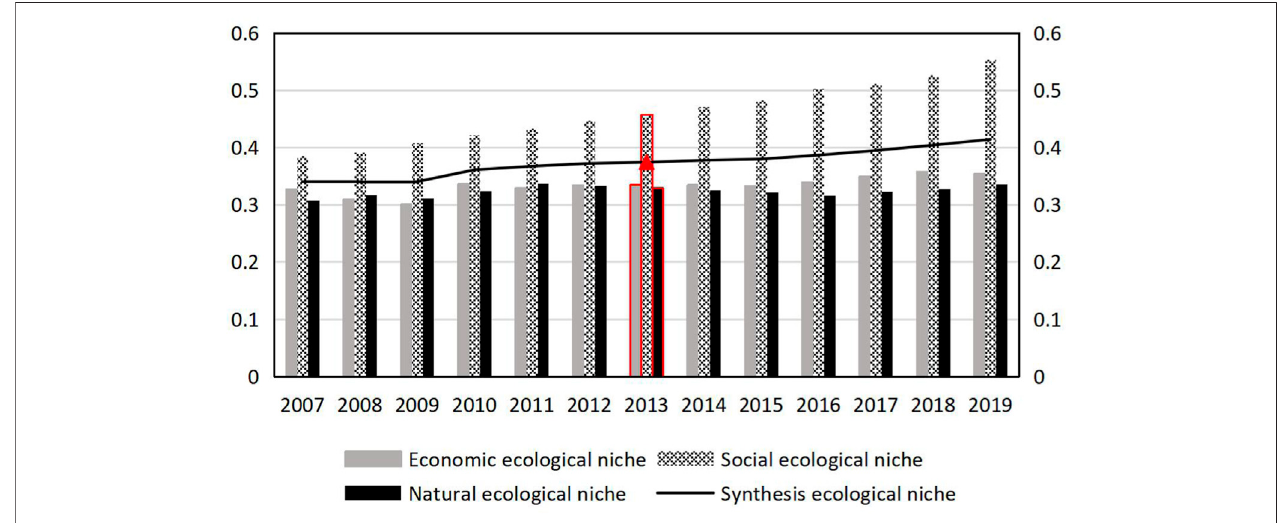
FIGURE 5 | Trends of social-economic-natural complex ecosystem in the CAFTA countries (2007 – 2019). The graph contains three subsystems and synthesis ecological niches, with the subsystems represented by bars and the synthesis ecological niches represented by